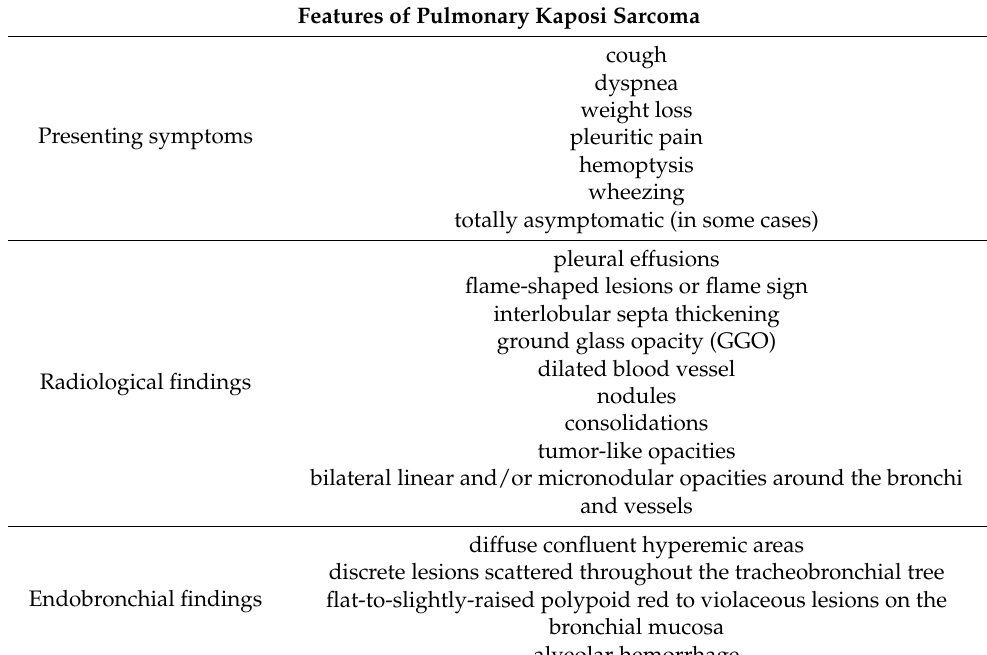
Table 1. Clinical, radiological, and endobronchial findings of